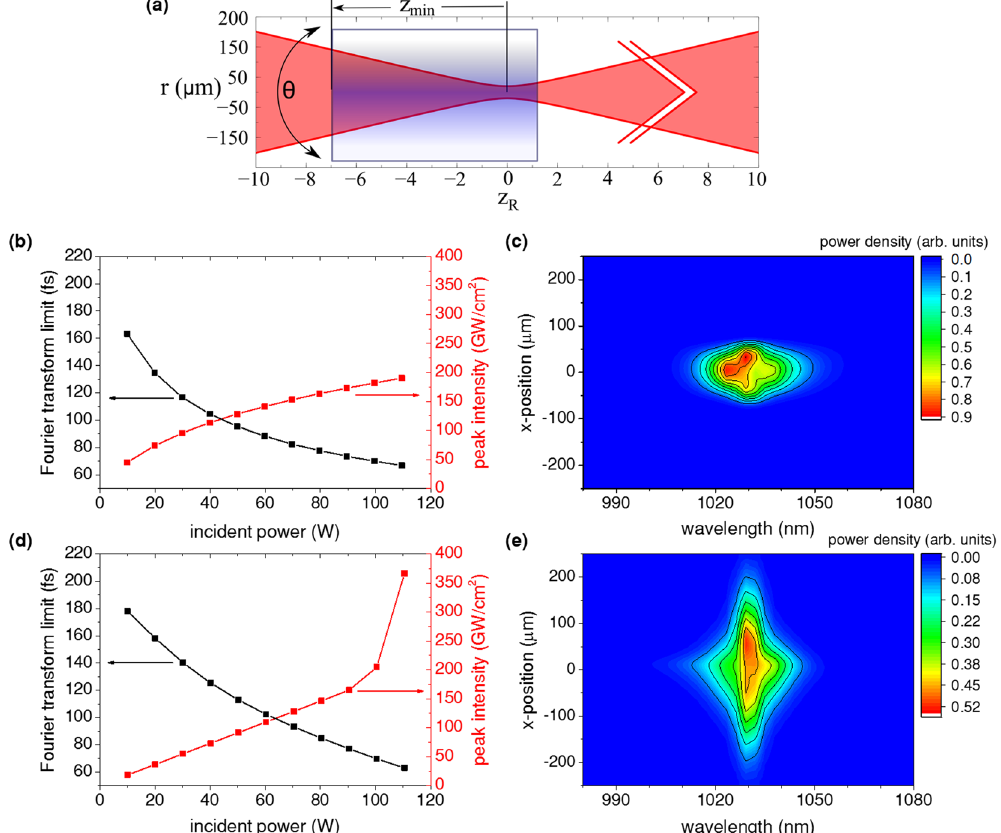
Figure 3. Simulations with an incoming 180 fs sech 2 -pulse, focused to a beam diameter of 40 μ m (in absence of nonlinear refraction): ( a ) Sketch of the simulation parameters. The tuning angle θ was varied to achieve self- 16 2 . They defocusing and -focusing, resp. The effective nonlinear refractive indices were = ⋅ − n 8 10 cm /W 2 resulted from the sum of Kerr and cascaded χ (2) effects in both cases. A hypothetical n 2(Kerr) = − 4 · 10 − 16 cm 2 /W was set in the self-focusing case to match the magnitudes of the contributions to n 2 . The distance from the crystal front facet to the focal plane was z min = − 7 z R ( − 8.5 mm, illustrated in the figure) in the defocusing and z min = 4 z R (4.9 mm) in the focusing case. This has been chosen to match Fourier transform limit and peak intensity at 90 W incident power. The Rayleigh length z R was about 1.22 mm, the crystal length 10 mm. The beam radius is denoted by r. The red arrows indicate the propagation direction (z-axis). ( b ) Dependence of the maximal peak intensity inside the crystal and the Fourier transform limit of the pulses on the incident power for negative effective n 2 and beam con vergence. ( c ) Spectral power distribution in dependence on the x-position with respect to the beam centre for negative effective n 2 and beam con vergence. ( d ) Dependence of the maximal peak intensity inside the crystal and the Fourier transform limit of the pulses on the incident power for positive effective n 2 and beam di vergence. ( e ) Spectral power distribution in dependence on the x-position with respect to the beam centre for positive effective n 2 and beam di vergence. ( c , e ) show line-outs at y = 0 μ m for 90 W incident